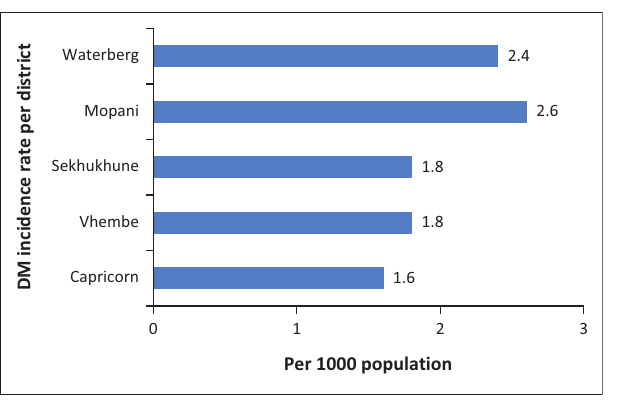
FIGURE 1: Diabetes mellitus incidence per province in South Africa.